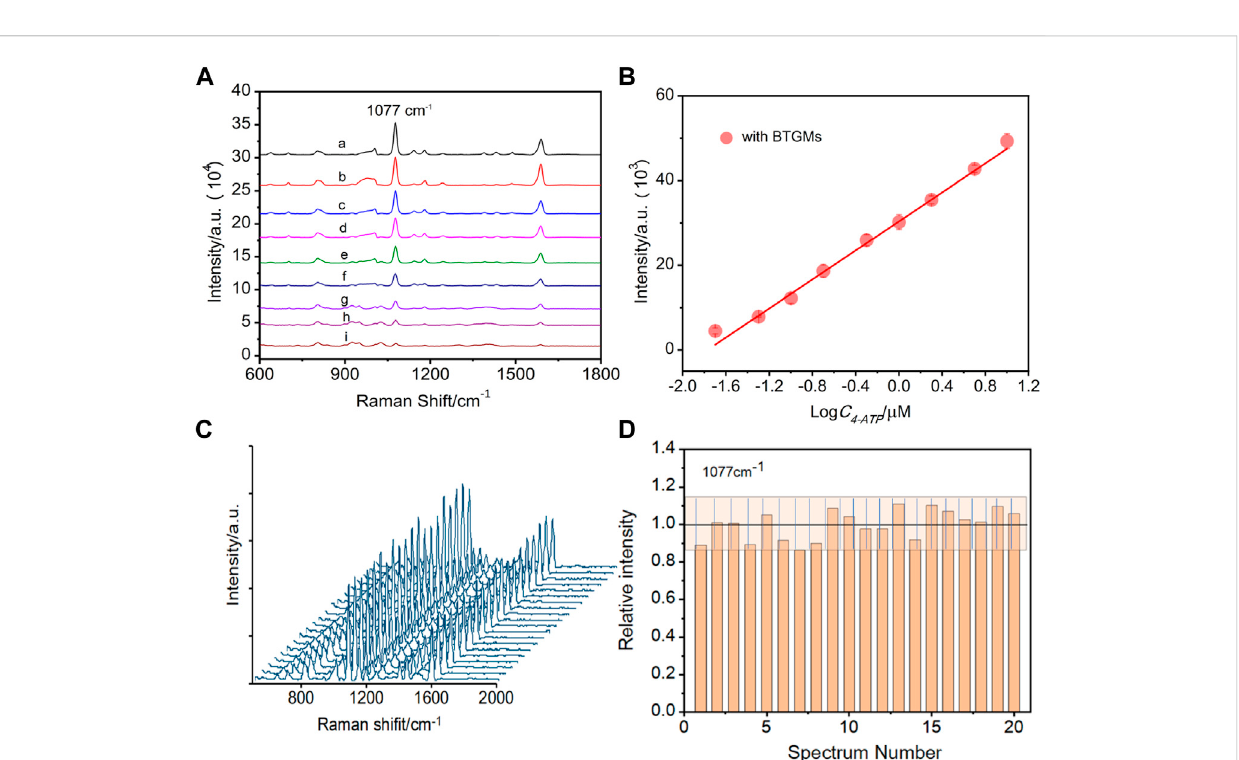
FIGURE 3 SERS spectra of different concentrations of 4-ATP obtained in the presence of BTGMs (A) (a – i: 10 μ M, 5 μ M, 2 μ M, 1 μ M, 0.5 μ M, 0.2 μ M, 0.1 μ M, 50 nM and 20 nM, respectively). (B) Linear relationship between the intensity at 1,077 cm − 1 of 4-ATP with its concentration. (C) SERS spectra of 4-ATP wereacquiredfrom20randomsiteswiththeDERSeffect(inthepresenceoftheBTGMs). (D) Correspondingbarchartforthepeakintensityat1,077 cm − 1 , the grating zone is indicated with ±13% intensity variation. DMs of 650 μ m and microchannel with a width and depth of 600 and 360 μ m, respectively, were